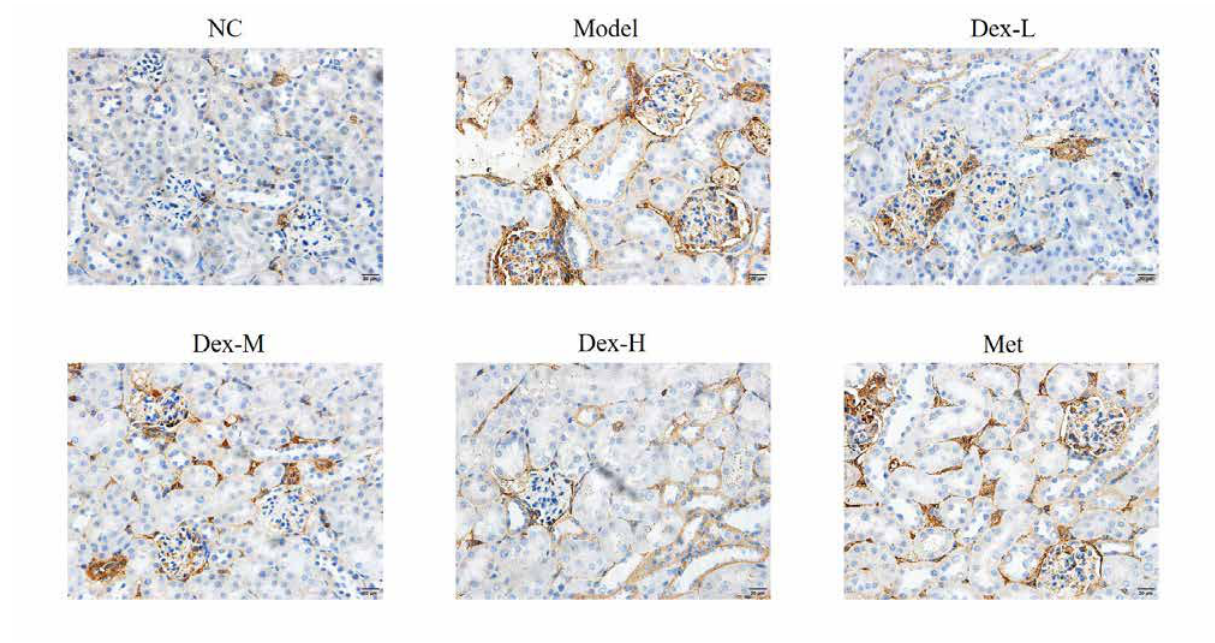
Figure 6: The p-MYPT protein expression of different groups by IHC assay (400×) NC: normal control group; Model: DN model group; Dex-L: Dex low-dose treated group; Dex-M: Dex medium-dose treated group; Dex-H: Dex high-dose treated group; Met: Metformin treated group